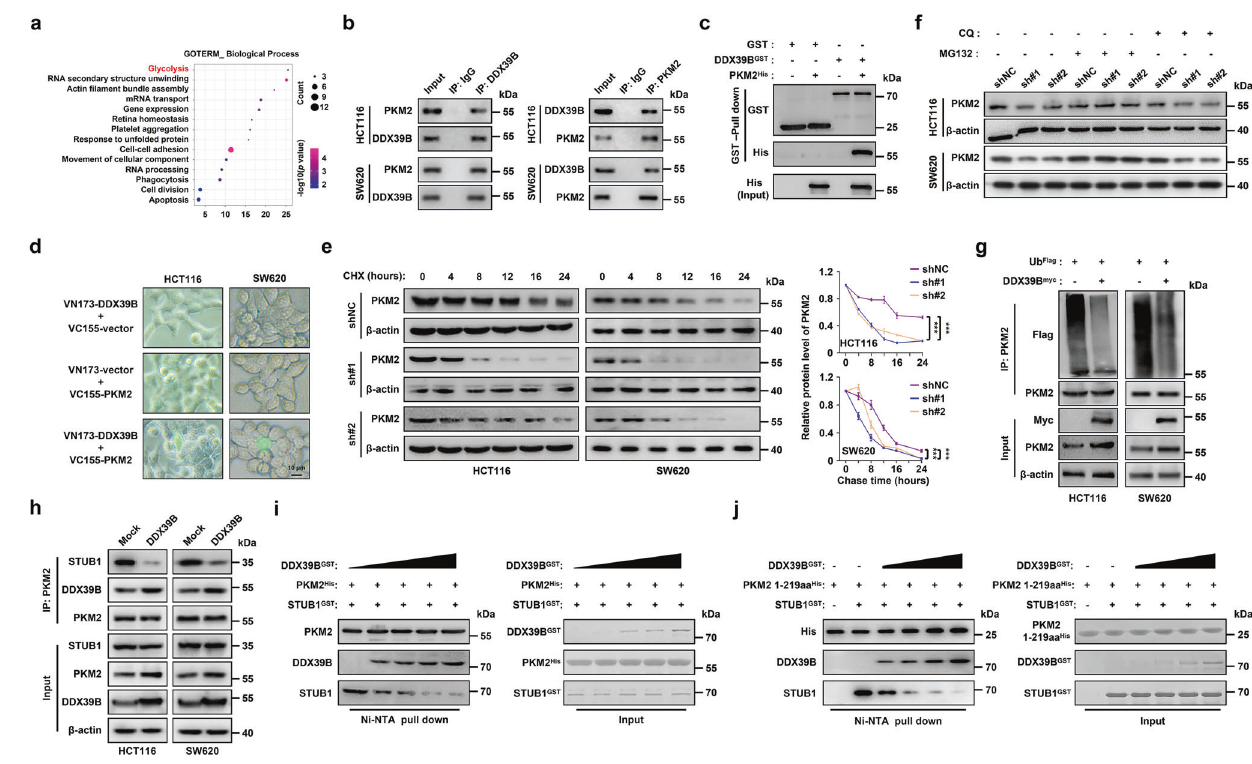
Fig. 4 DDX39B interacts with PKM2 and reduces its degradation. a The Gene Ontology analysis of DDX39B interactome. b The endogenous interaction between DDX39B and PKM2 was examined by immunoprecipitation assay in CRC cells. c GST pull-down assays were carried out with bacterially expressed GST-fused DDX39B and His-fused PKM2. d HCT116 and SW620 cells were transfected with pBiFC-VN173-DDX39B and/or pBiFC-VC155-PKM2, and the fl uorescence signals were imaged. e The degradation of PKM2 protein in DDX39B knockdown CRC